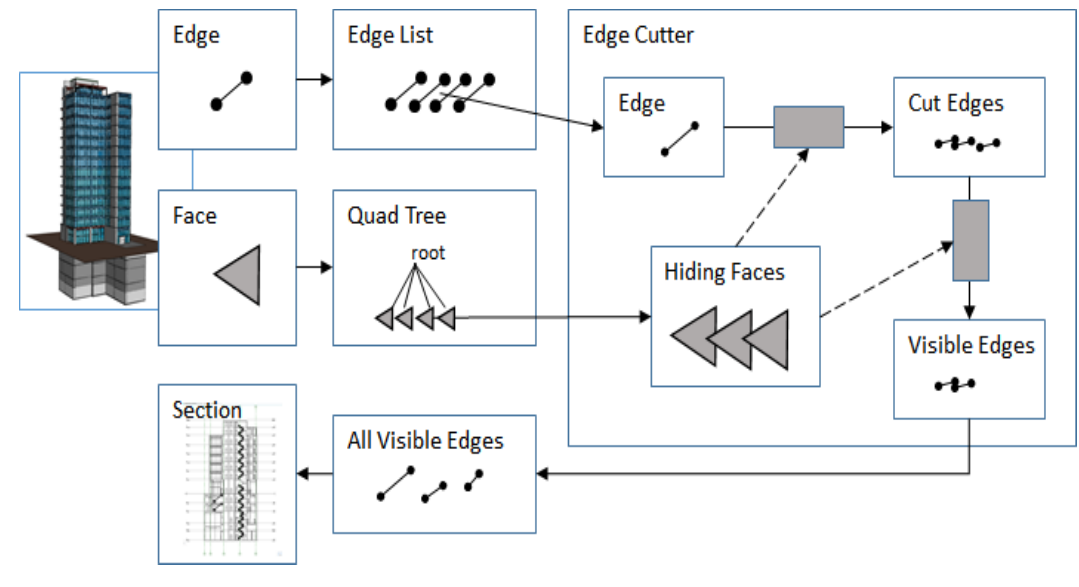
Figure 3. Perimeter and outline of the elevation.